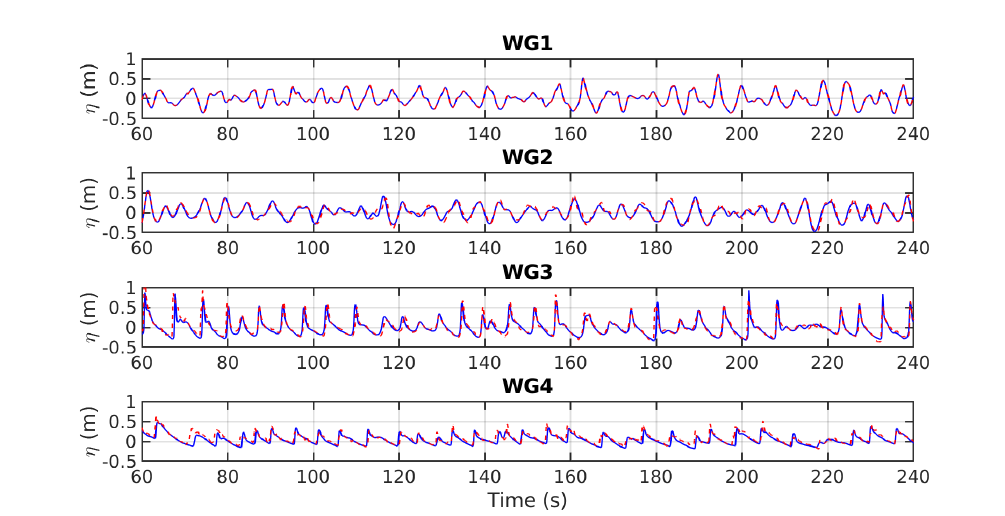
Figure 6. Comparisons between observed (red dashed line) and computed (blue solid line) free surface time series at different cross-shore locations for case DR0.